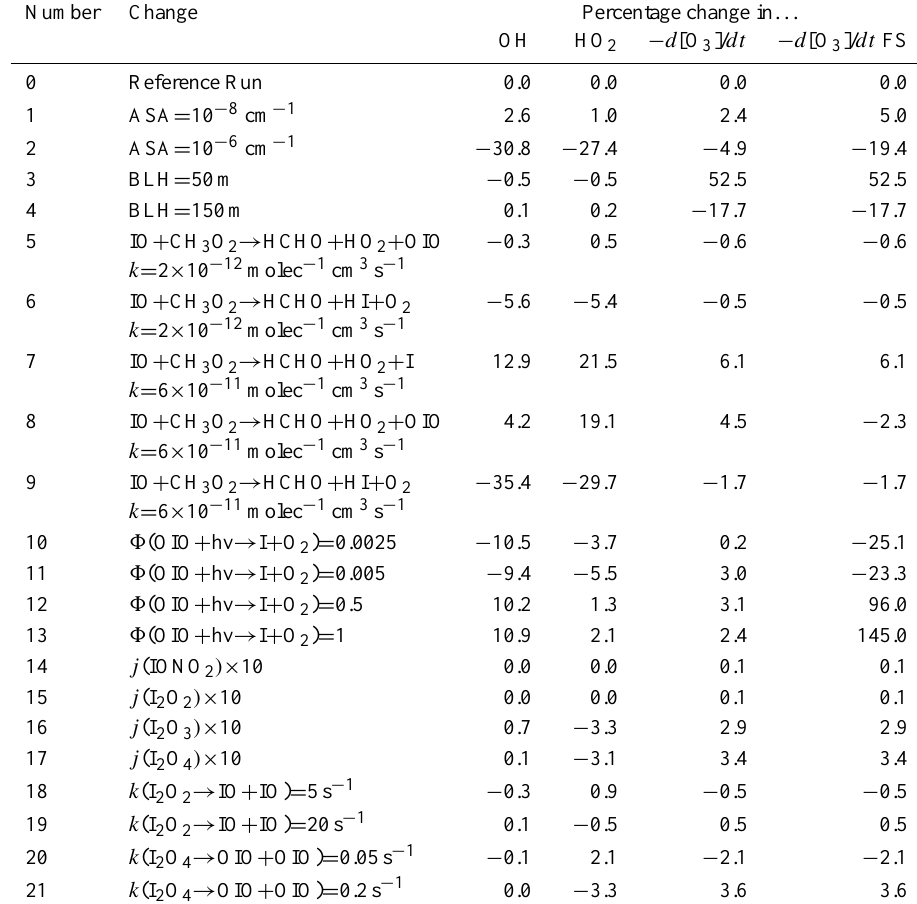
Table 4. Model sensitivity